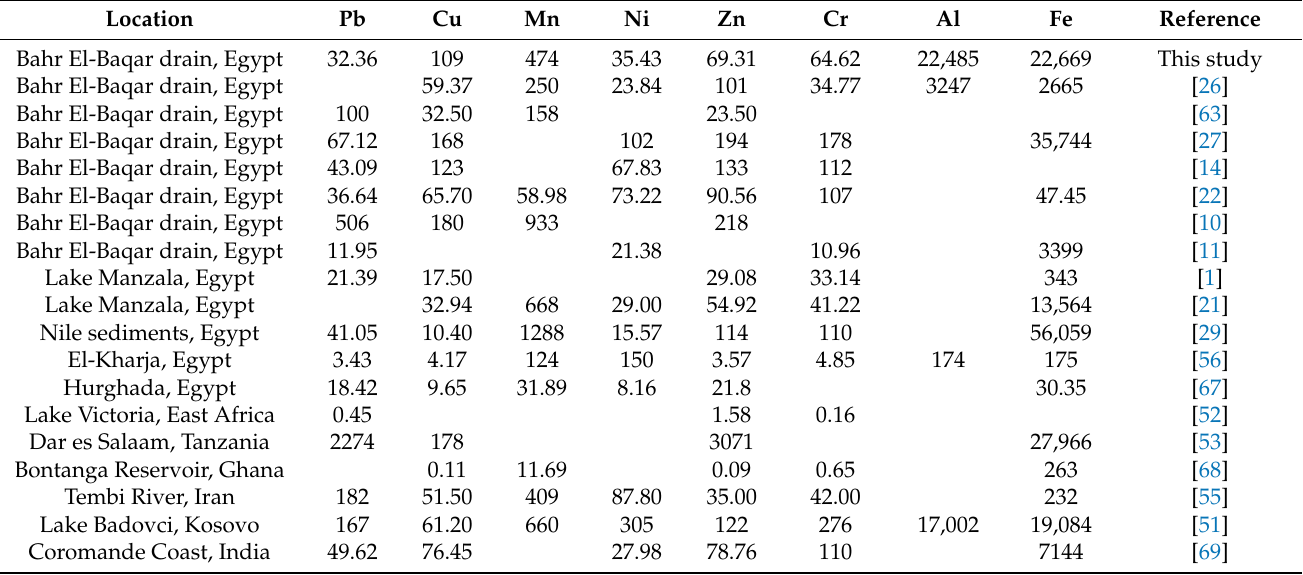
Table 4. Average concentrations of heavy metals (mg/kg) in the studied sediments compared to those of national and international